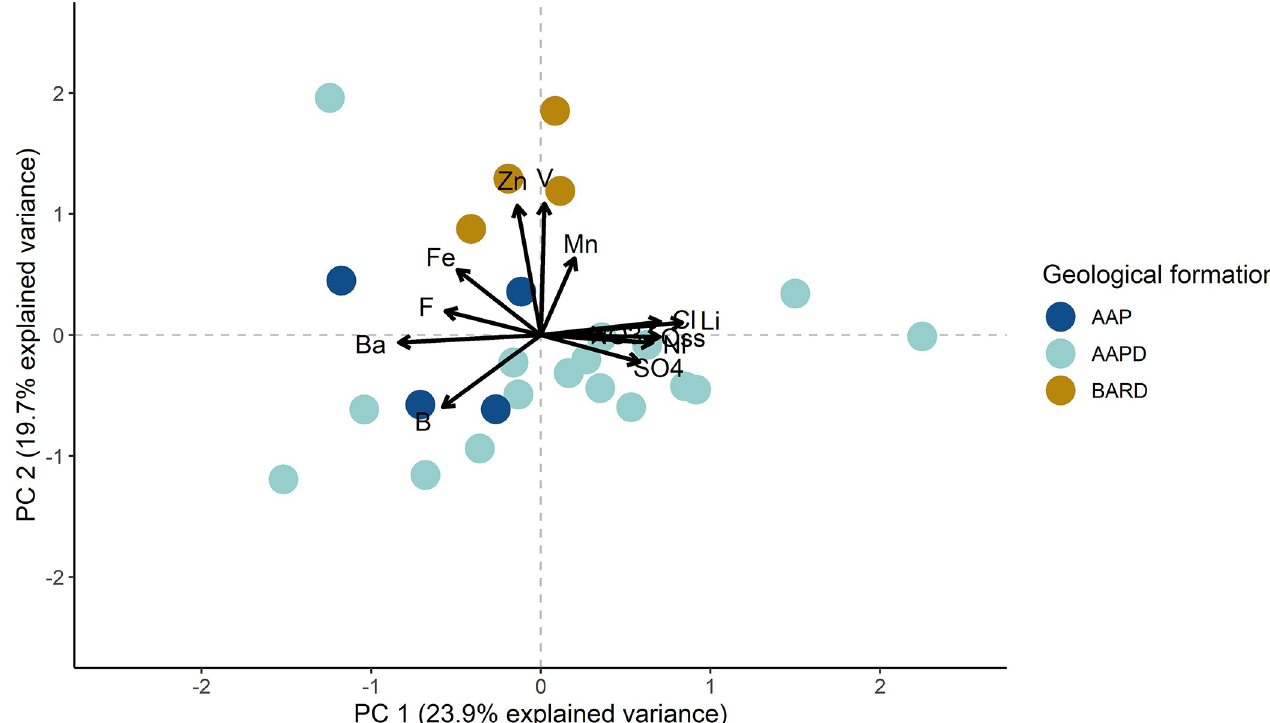
Fig 12. Plot of PCA2 (only spring water samples) according to geological formation. Acronyms are used for permanganate oxidation (Oss), NO 3- (NO3), Cl - (Cl), F - (F), and SO 42- (SO4).